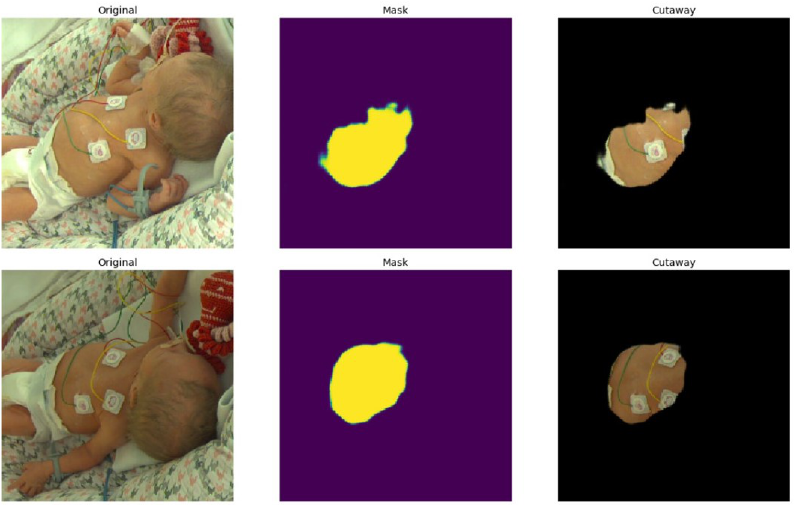
Figure 5. This figure represents how the UNET-based ROI detector finds the torso of the newborn baby. Middle images show the predicted masks. Right images represent the masked